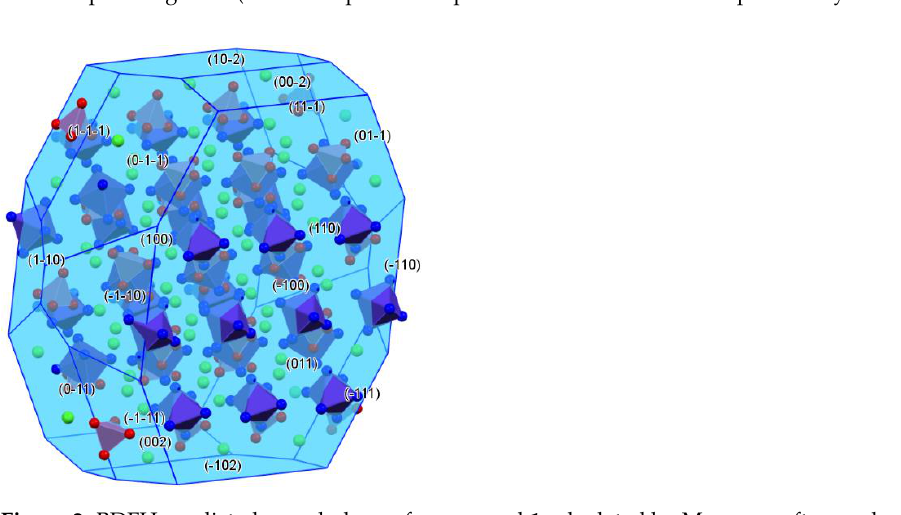
Figure 2. BDFH-predicted morphology of compound 1 calculated by Mercury software showing the { − 100} facet in front (hydrogen atoms were omitted for clarity).